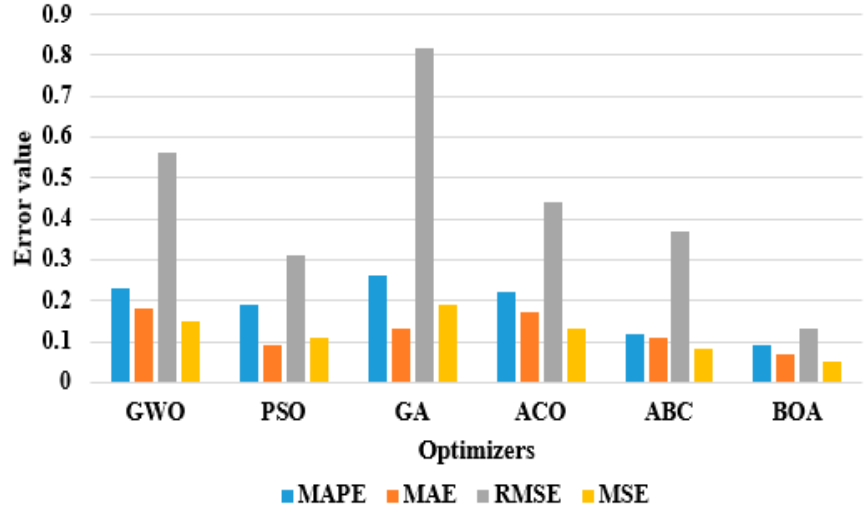
Figure 8. Graphical presentation of the dissimilar hyperparameter optimizers in the LSTM network on the AEP dataset.